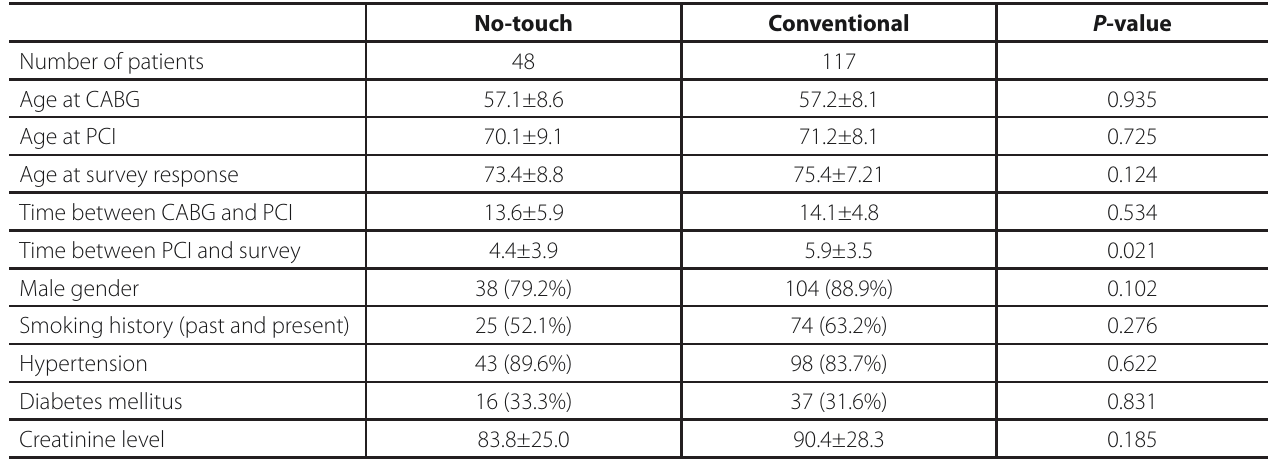
Table 1. Demographic